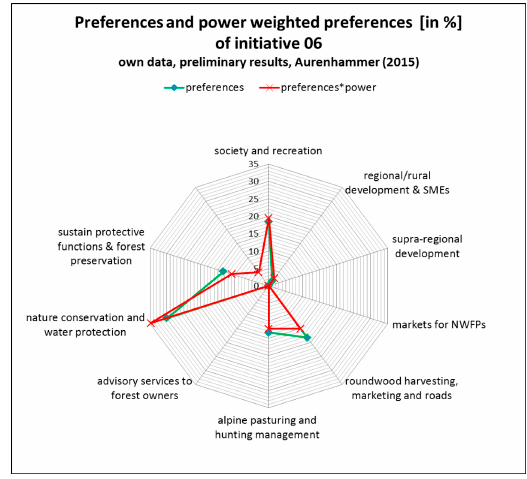
Figure A1. On the top: table to be used to summarize interviewee’s responses on other actors roles (capacities, willingness); below: SNA-based results, e.g., tables on influence, figures on goal priorities and fulfillment of the specific initiative, used as background-material for